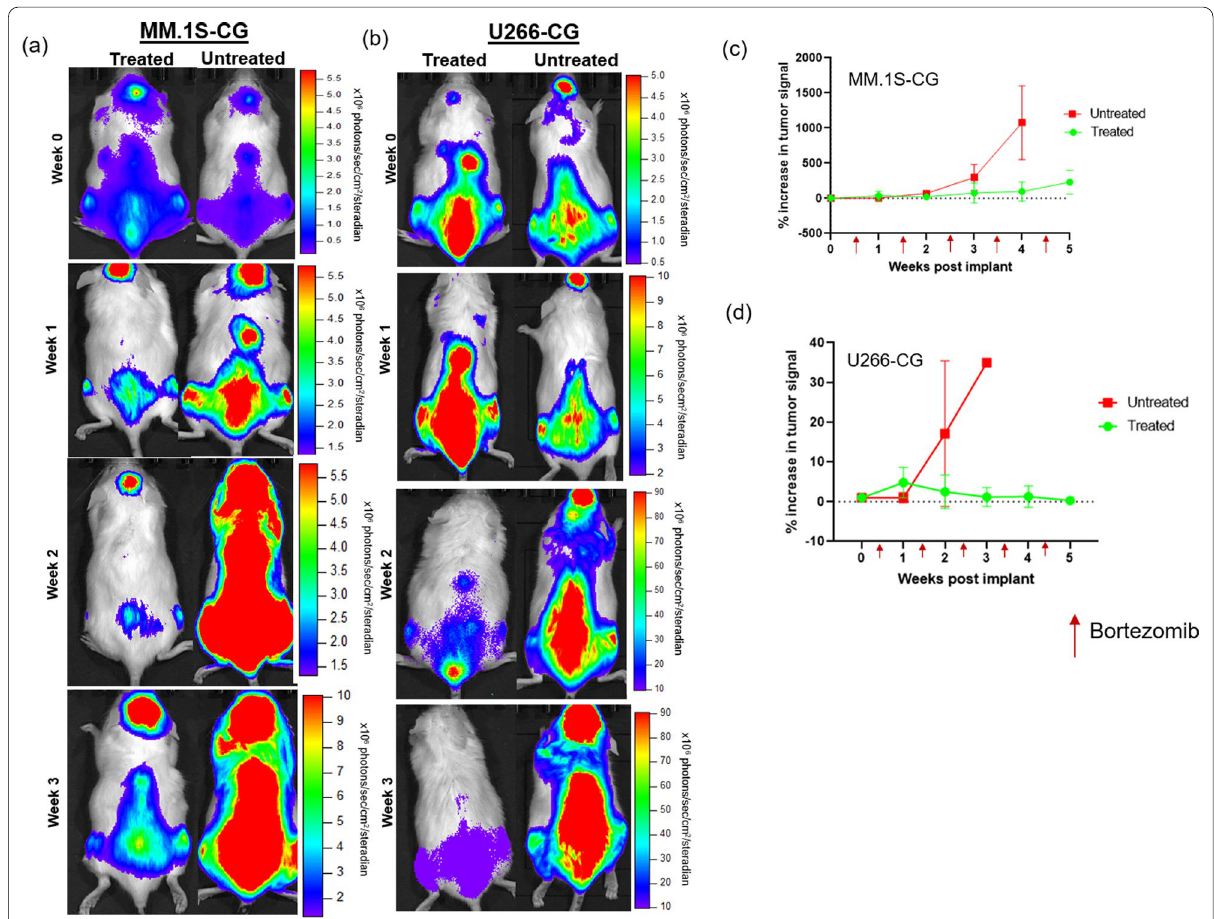
Fig. 2 a , b Representative BLI images of mice injected with MM.1S-CG and U266-CG cells, respectively (treated and untreated cohorts), showing systemic tumor progression and response to bortezomib therapy over time. c , d Percent increase in bioluminescence signal intensity showing tumor progression in treated and untreated cohorts plotted as a function of time (weeks post-tumor